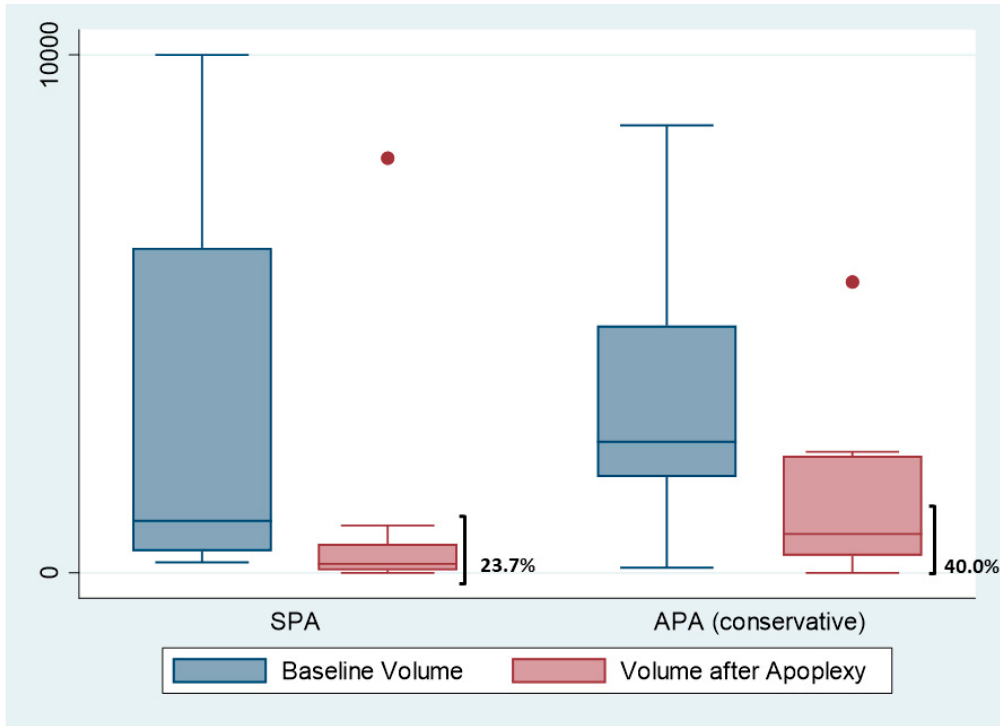
Figure 4. Initial volume and after 12 months of apoplexy. The figure shows the boxplots of the tumor' volume reduction in subclinical apoplexy (SCA) and acute apoplexy (AA) treated conser- vatively. Dots are